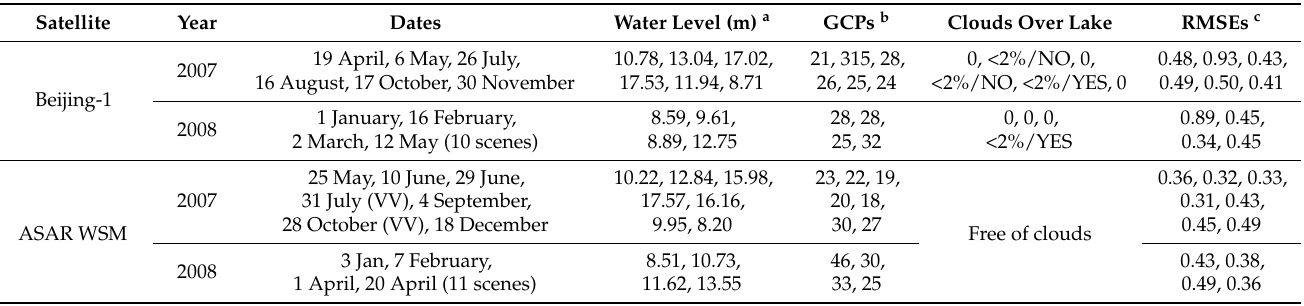
Table 1. Satellite data used in this